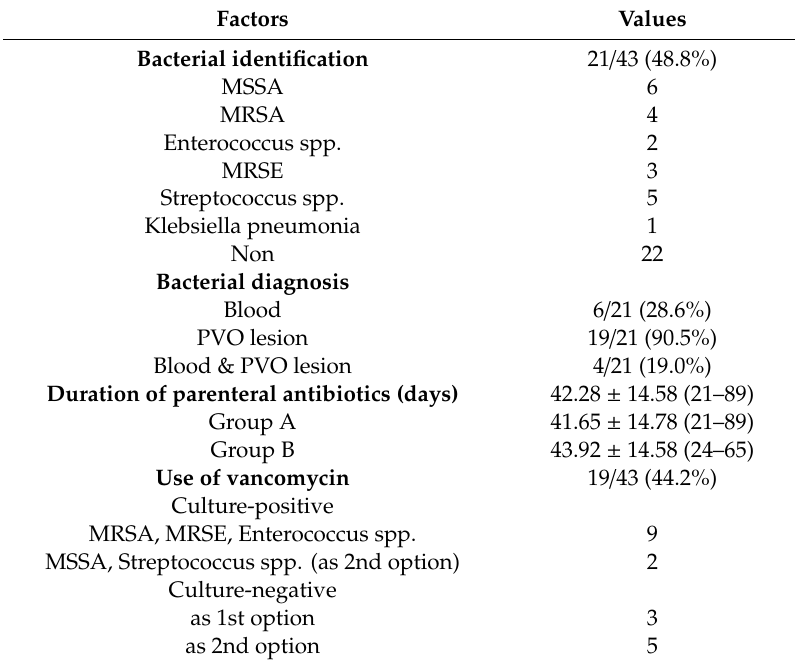
Table 2. Characteristics of bacteriology and